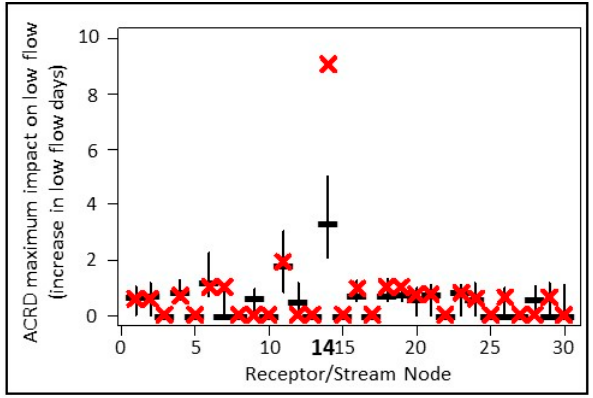
Figure 10. Distribution of ACRD maximum impact on low flow days, modelled using 100 stochastic replicates (plots show median and 10th and 90th percentile values, the red crosses show results when the 1923–2012 rainfall sequence is used (as in Figure 4).